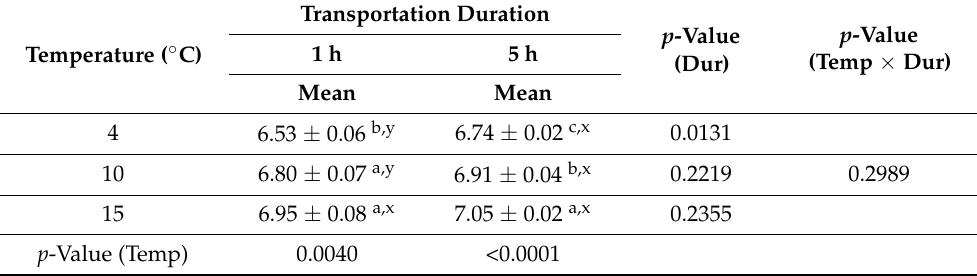
Table 7. Effects of transportation temperatures (4 ◦ C, 10 ◦ C, and 15 ◦ C) for two different transportation durations (1 and 5 h) on the Salmonella population (log 10 ) of pectoralis major muscles in broiler